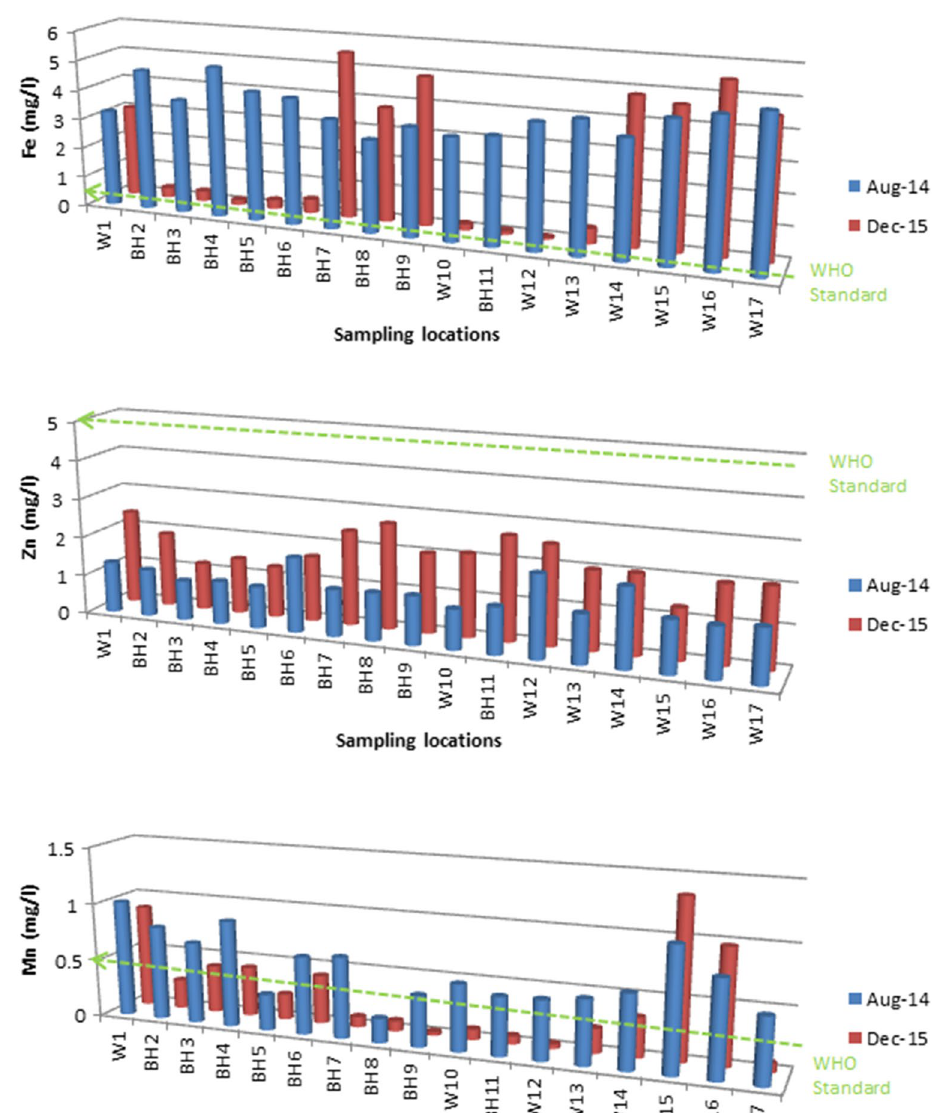
Fig. 13 Seasonal variations in Fe concentration of water sample versus WHO standard around the Olusosun dumpsite